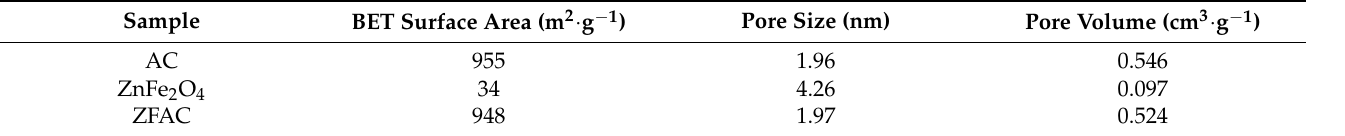
Table 1. BET surface area, pore size, and pore volume of AC, ZnFe 2 O 4 , and ZFAC.